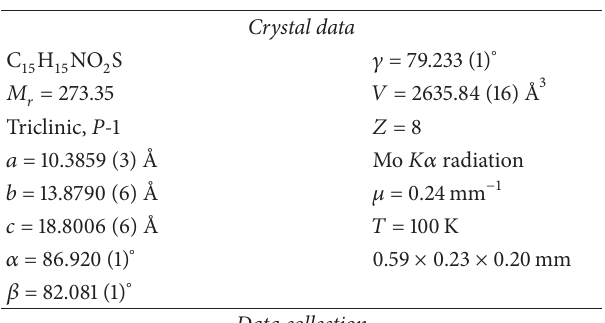
Table 2: Bond lengths and bond angles of compound 2 (˚A, ∘